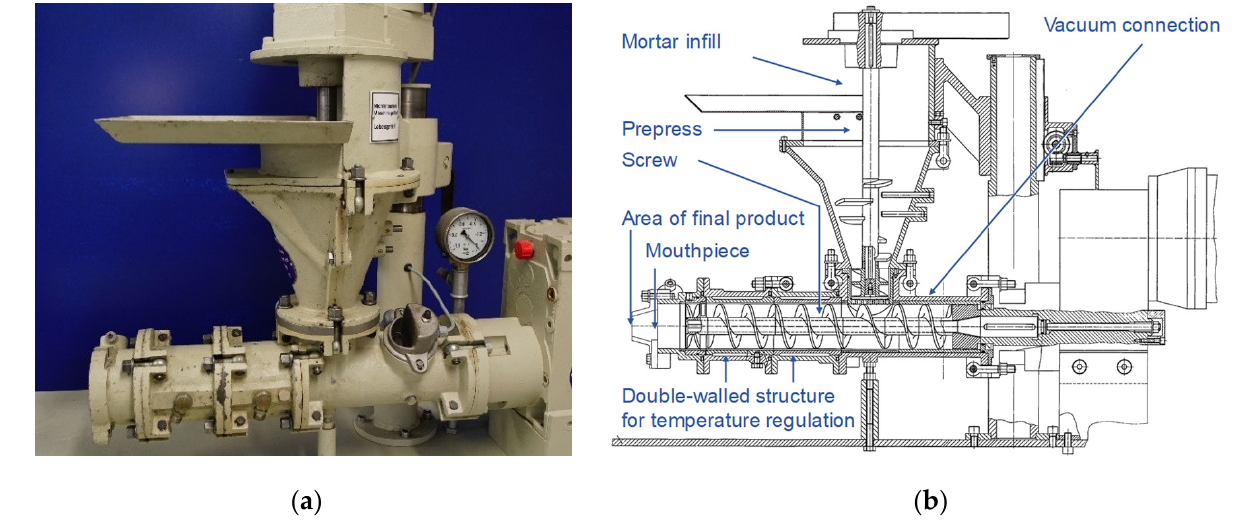
Figure 2. ( a ) Laboratory mortar extruder [5] and ( b ) schematic drawing of the laboratory mortar extruder [5].